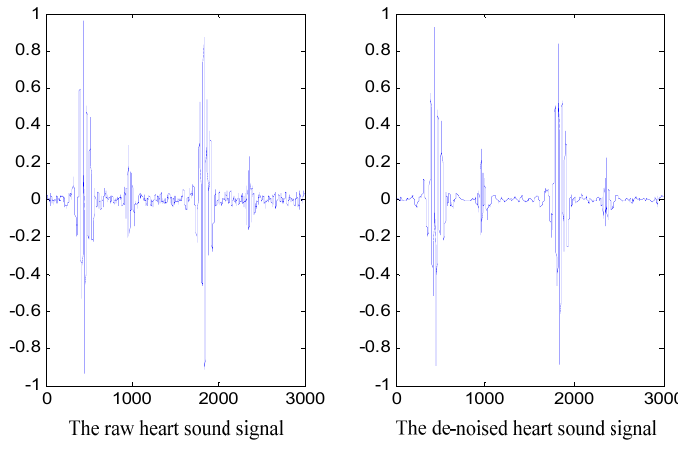
Figure 8. Raw heart sound signal and the corresponding de-noised